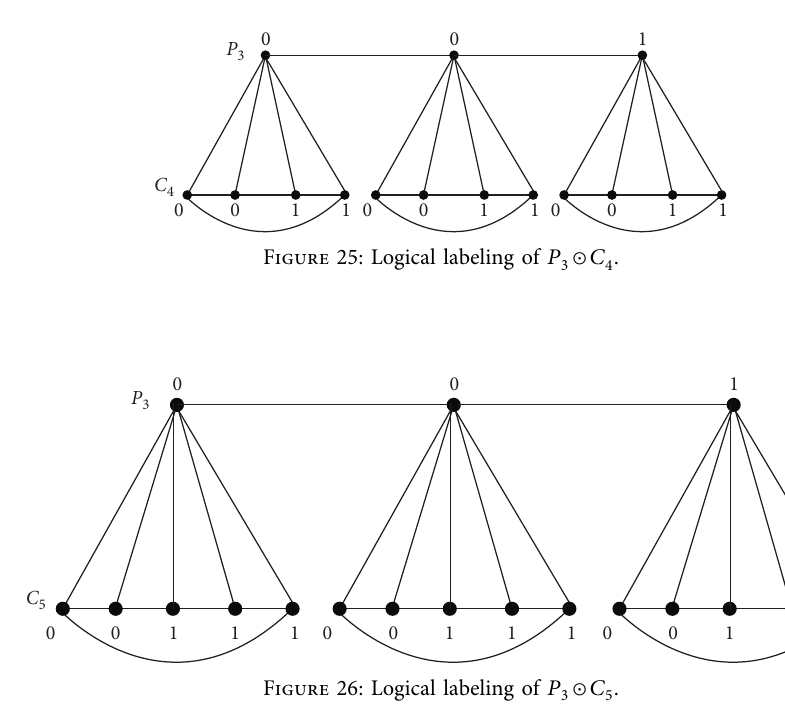
Figure 24: Logical labeling of P